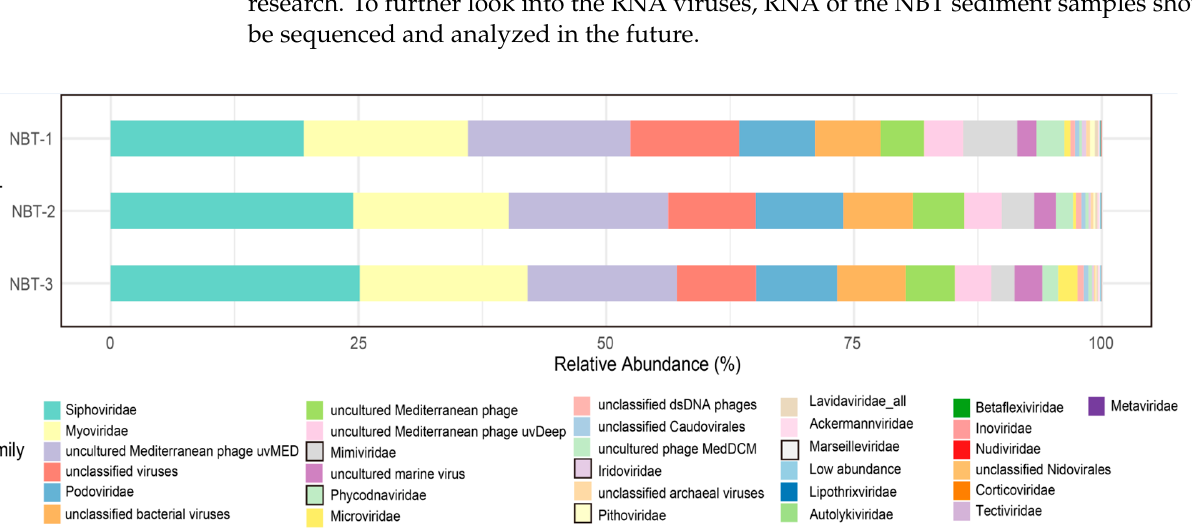
Figure 2. The relative sequence abundance of viral communities of three layers in NBT sediment (top 30). Viral communities shift at the family level. The raw relative abundance data was provided in Supplementary Table S2. Taxonomic assignment of clean reads was performed using Kaiju with NCBI nr database. NBT-1, the surficial layer NBT-1 (sediment depth 1–5 cm); NBT-2, the mid-layer (sediment depth 5–10 cm); NBT-3, the deep layer (sediment depth 10–15 cm).The black frame indicates NCLDV.